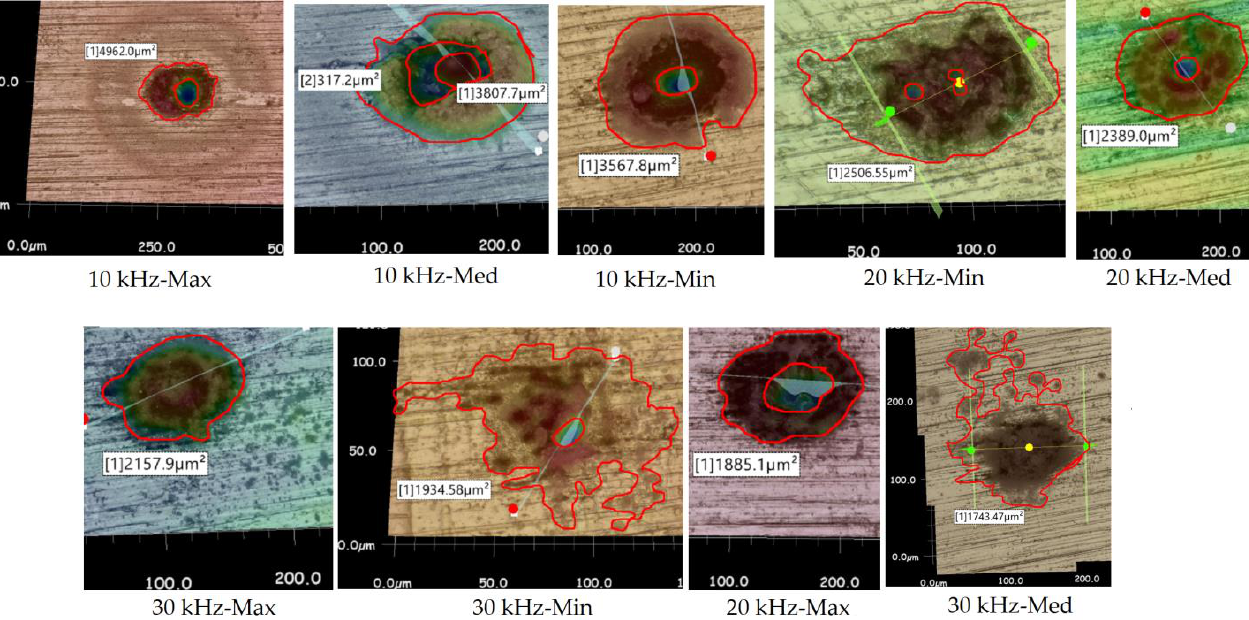
Figure 9. Spatter areas measured by 3D microscopy from the highest SA to the lowest: 10 kHz-Max, 10 kHz-Med, 10 kHz-Min, 20 kHz-Min, 20 kHz-Med, 30 kHz-Max, 30 kHz-Min, 20 kHz-Max and 30 kHz-Med.